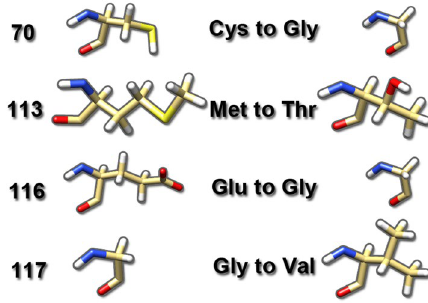
Figure 3. The four amino acid residues are located in the actin-binding domain of PFN-1. The Cys 70 to Gly is a polar amino acid with uncharged R groups changed to a nonpolar amino acid with the smallest R group. The Met 113 to Thr mutation is a nonpolar amino acid with an aliphatic R group changed to a polar amino acid with an uncharged R group. The Glu 116 to Gly is a negatively charged R group changed to a nonpolar amino acid with the smallest R group. The Gly 117 to Val is a nonpolar aliphatic residue that is substituted to Val, with the same nonpolar aliphatic R